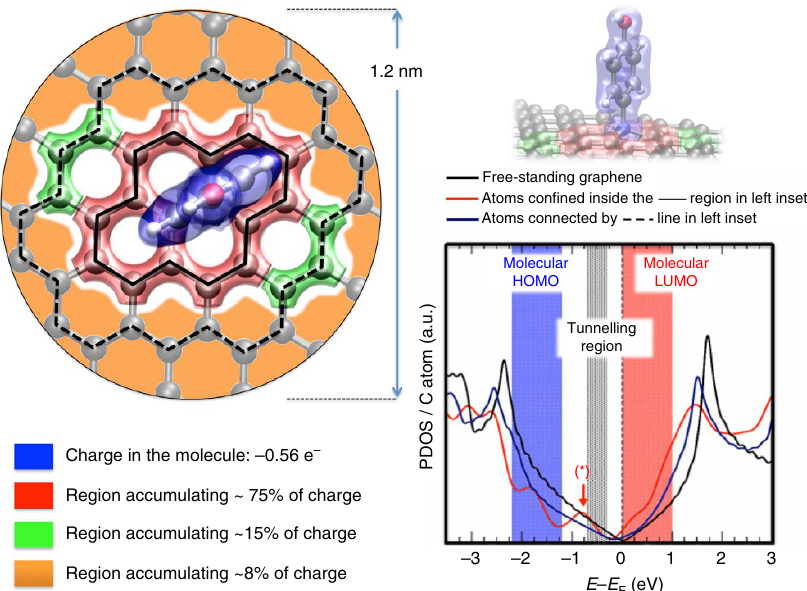
Figure 3 | Charge redistribution in the region around the molecule upon covalent bonding. (Left panel) Pictorial sketch showing that most of the net charge provided by the molecule ( B 75%) is accumulated and distributed among the nearest C atoms (red shadowed region), B 15% among more distanced C atoms (green shadowed regions) and the rest ( B 8%) among the rest of the C atoms of the graphene sheet (orange background). (Right panel) Projected density of state profiles per C atom (PDOS/C atom; in a.u.) versus energy (referred to the Fermi level; in eV) onto different sets of C atoms as we increase the distance from the N atom: (solid-red line) C atoms confined inside the region delimited by the solid-black line in left panel; and (solid-blue line) C atoms connected by the dashed-black line in left panel. For comparison, we also show the density of states per C atom in free-standing graphene (solid-black line). Shadowed in different colours are the molecular HOMO (blue) and LUMO (red) position of the molecule, and the tunnelling region of the experimental images (grey). (*) denotes a N related electronic state on the neighbouring C (solid-red line in right panel of Fig. 3). For comparison, in right panel of Fig. 3 we also show the density of states per C atom in free-standing graphene (solid-black line). It is important to notice that for the PDOS profile for C atoms of the closest-to- N region—within the solid line–, the resembling of pristine graphene DOS is quite poor, and some induced features arises just above and below associated to a reflection of the electronic properties of the positively charged molecule. In particular, the one arising between (cid:2) 1 and 0 eV—labelled as (*) in right panel of Fig. 3—corresponds to an induced density of states by N on their closest C atoms. On the other hand, the highly hybridized molecular HOMO and LUMO positions are indicated as blue and red shadowed region, respectively, and they have visibly spread out by effect of the chemical interaction. The tunnelling region, where experimental images were recorded ( (cid:2) 0.7/ (cid:2) 0.3 eV) is also indicated in the right panel of Fig. 3. Interestingly, the tunnelling region does not overlap at all with the molecular HOMO, which explains the lack of STM signal coming from the molecule in the image.